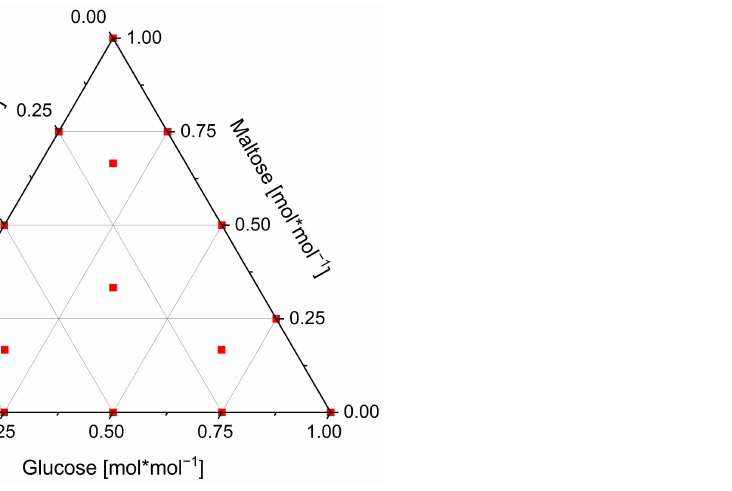
Figure 1. Simplex experimental design of the investigated ternary glucose–maltose–maltotriose